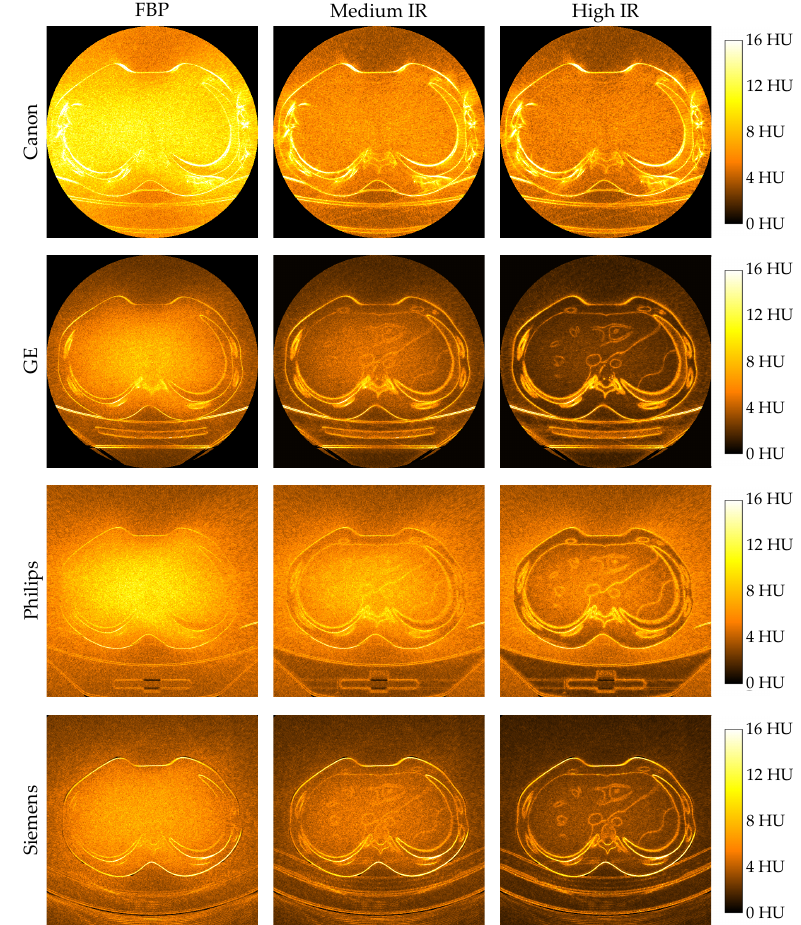
Figure 2. Noise maps showing the inter-image pixel standard deviation for 30 images, each reconstructed with filtered back projection (FBP), a medium level of iterative reconstruction (IR) and a high level of IR for all vendors. A lighter color indicates a higher standard deviation, an thus a higher level of noise, in the given